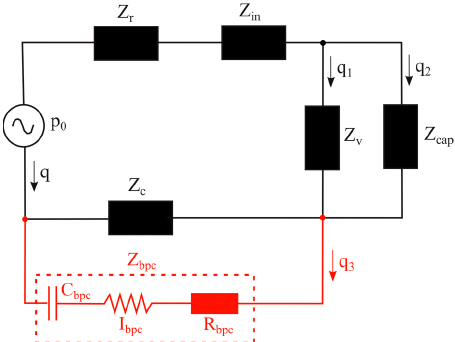
Figure A2. Equivalent electrical circuit representing the lumped element model (LEM) of the MEMS condenser microphone (MEMS CMIC) adapted with pneumatic access for static pressure equalization (SPEQ) required as soon the microphone is sealed (red highlighted circuit). The black part of the circuit represents a standard LEM of an MEMS CMIC, as given in References [25,26]. Z r : acoustic radiation impedance; Z in : inlet channel (pressure port); Z cap : diaphragm, back plate and electrical impedance of the capacitor; Z v : vent channel(s) for SPEQ; and Z c : back cavity.